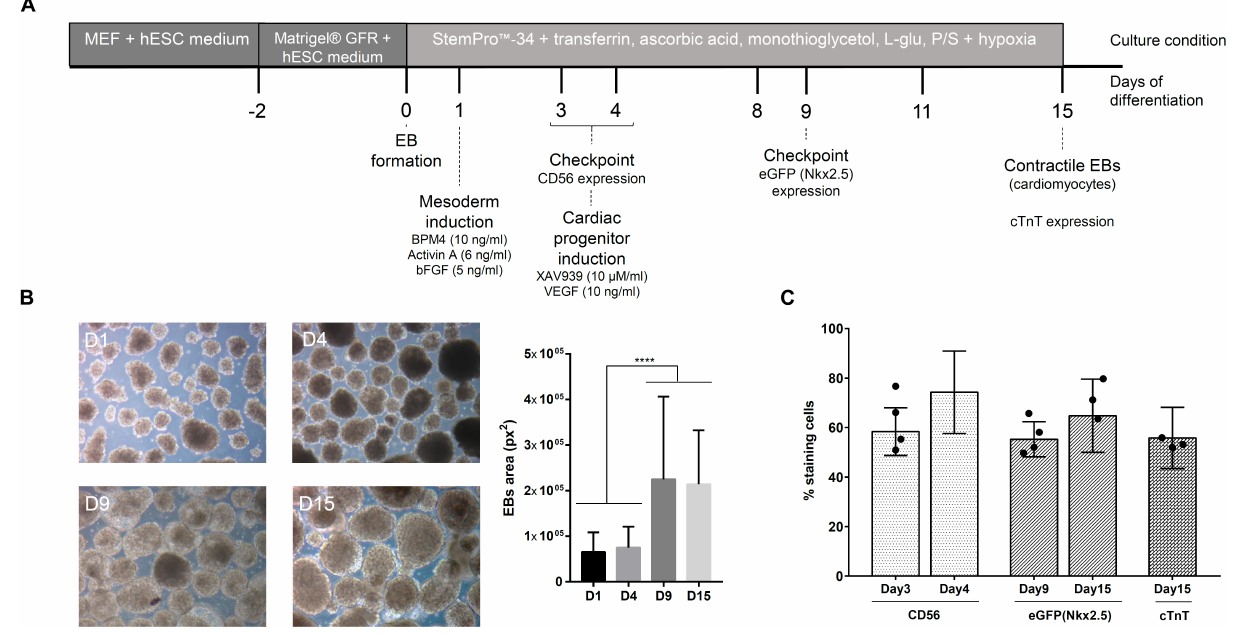
FIGURE 1 | Cardiomyogenic differentiation of hESCs. (A) Timeline of the cardiac differentiation protocol. (B) Representative images of embryoid bodies (EBs) during differentiation and the measurement of their size (manual measurement at ImageJ software) ( n = 10 images). **** p -value < 0.0001; statistical analysis was performed using one-way ANOVA and Tukey’s posttest. (C) Percentage (mean ± SD) of cells positive for different markers during cardiac differentiation (CD56 – mesoderm; eGFP/Nkx2.5 – cardiac progenitor; cTnT – cardiomyocytes) ( n = 6); the black dots represent the percentage of respective markers in cell population selected for experiments used for MS